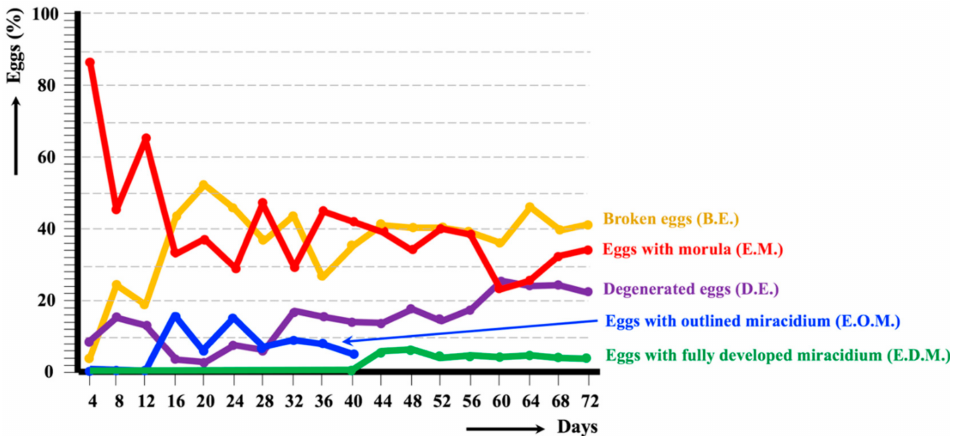
Figure 4. Graph showing the results of the experimental follow-up study of the egg embryonation of the isolate of Fasciola hepatica obtained from llama bile aspirate, and analyzed at 4-day intervals and constant temperature of 20 ◦